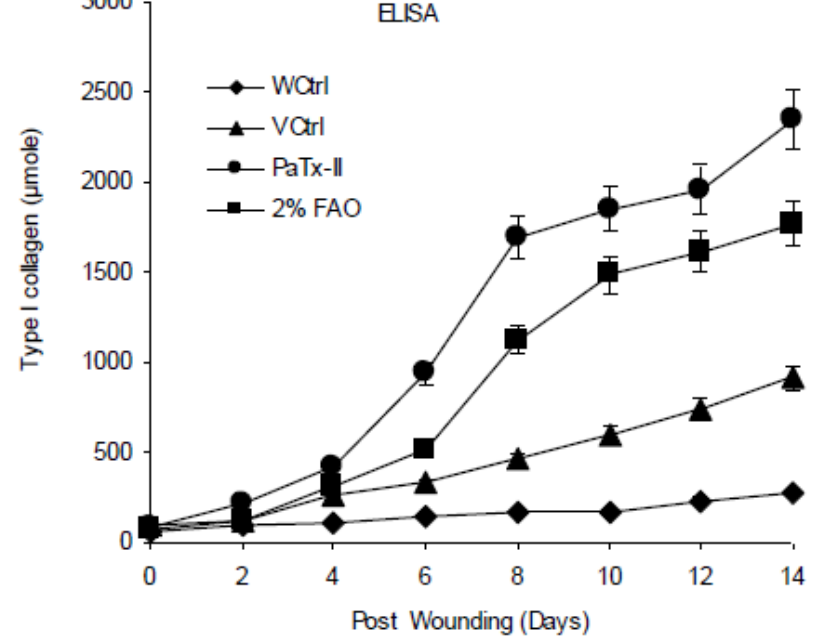
Figure 6. Wound fluid bacterial killing assay based on colony forming units (CFU/mL). ( A ) PaTx-II effectively inhibited the growth of S. aureus and completely cleared the growth of bacteria after 14 days versus the control. Graphical representation of wound fluid (WF) shows the percentage inhibition